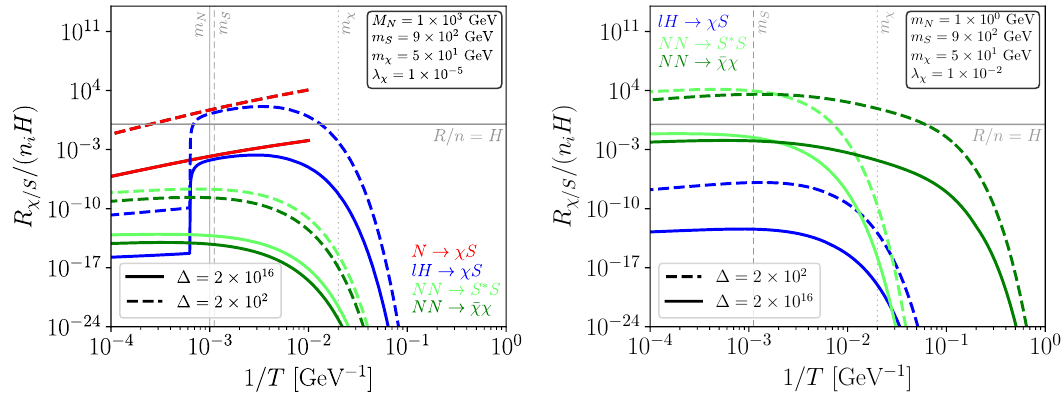
Figure 6 . Ratios between the DM production and the Hubble rates for the decay (red), s-channels (blue) and t-channels (green), in the case of small and large entropy production (dashed and solid lines, respectively). In the left (right) panel we have m N > m (cid:31) ; m S ( m N < m (cid:31) ; m S ). Notice that, the longer the EMD era, the easier to satisfy the out-of-equilibrium conditions, allowing for larger couplings in the freeze-in